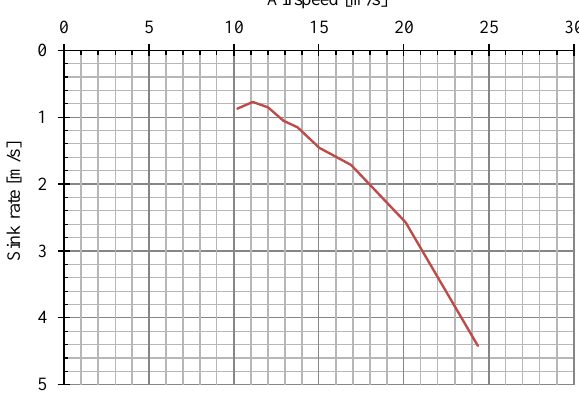
Figure 6 Glide polar of VUT712 at 3100g